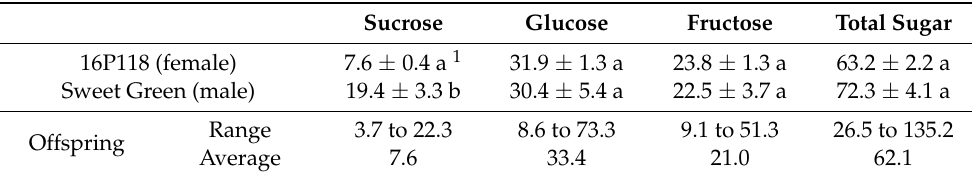
Table 1. Mean and range for sugar content in onion bulbs from 16P118 and Sweet Green and ranges of offspring from mapping population of 16P118 Ψ Sweet Green (mg g − 1 ).